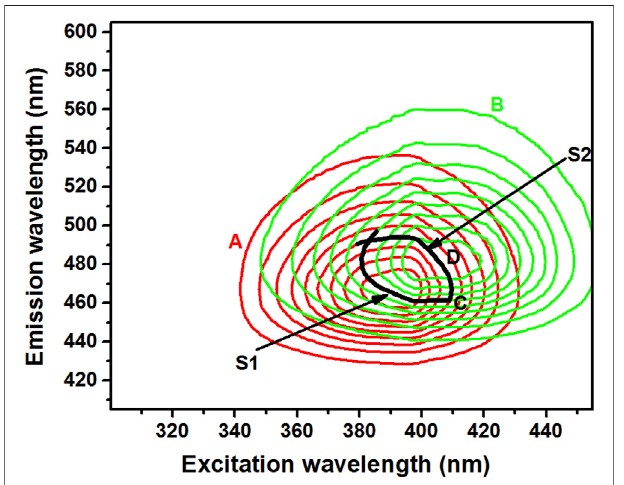
FIGURE 2 | Contour maps of δ -ALA [ (A) , 2.5 μ mol L − 1 , red solid line], PBG [ (B) , 6.5 μ mol L − 1 , green solid line], point of contact (C) and the selected isopotential scanning route [ (D) , black solid line].